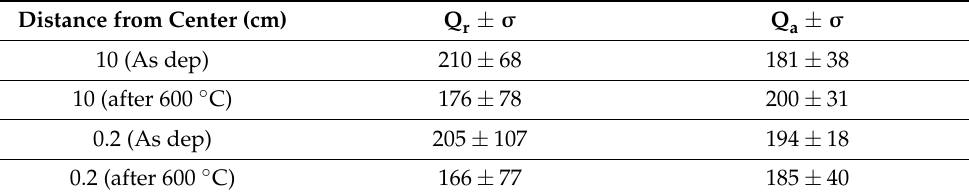
Table 2. Measured Q r and Q a